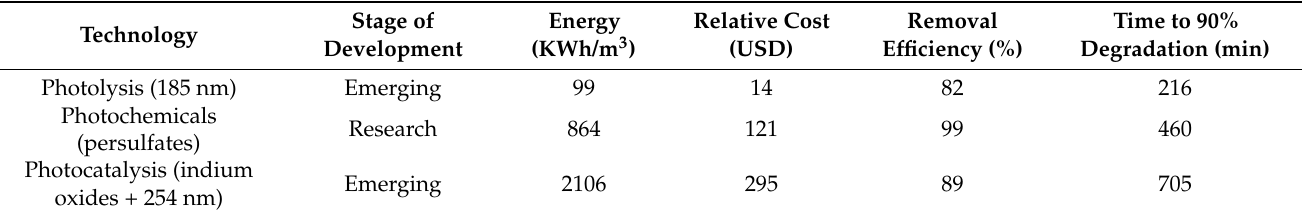
Table 3. Relative cost comparisons between the most successful employed techniques employed for PFAS degradation (adapted from